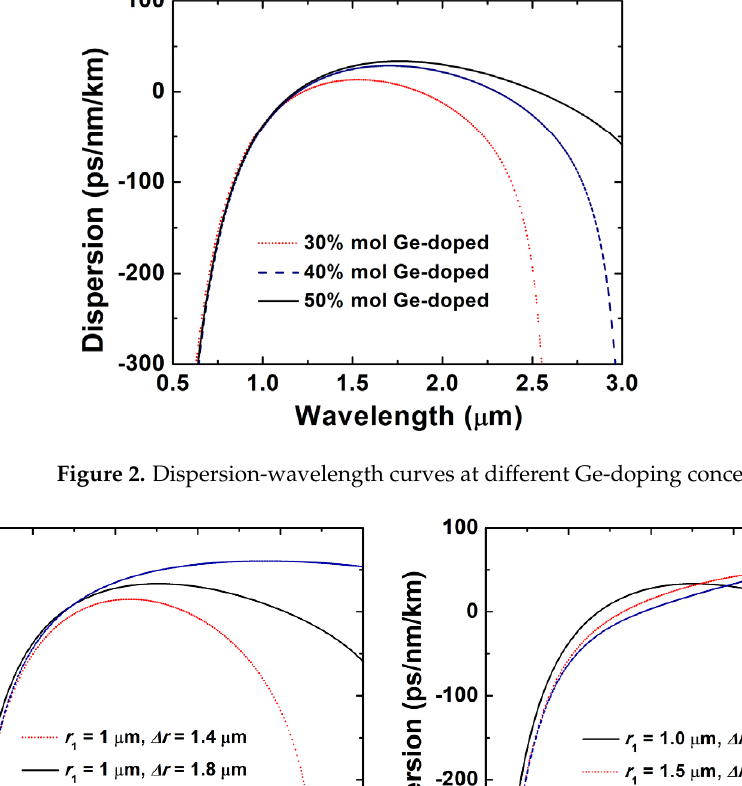
Figure 2. Dispersion-wavelength curves at different Ge-doping concentrations.